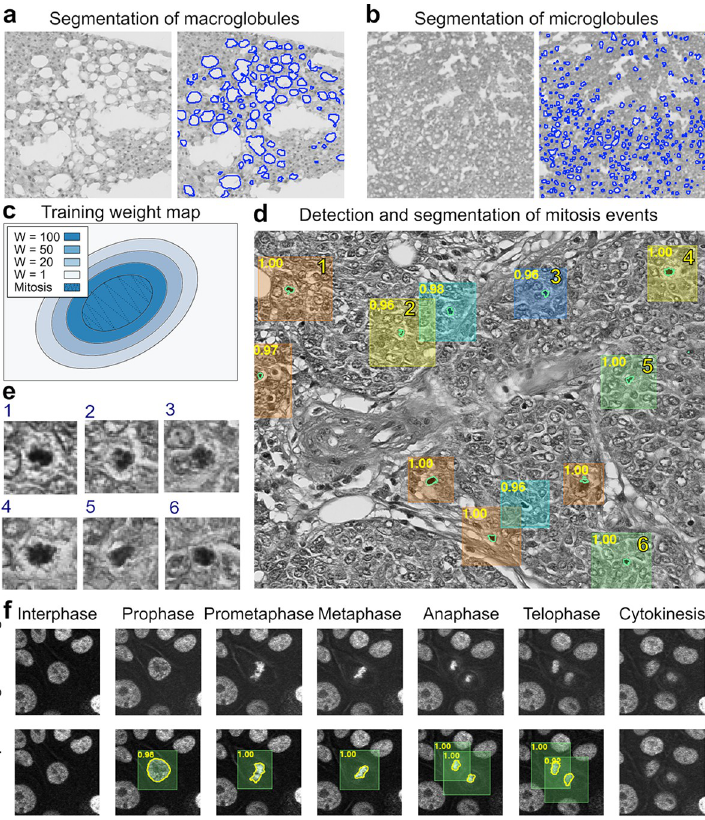
Fig 5. NuSeT can be applied to segment histopathology samples and detect mitotic events. (A, B) Representative example of liver fat globule segmentation using NuSeT. Notice that NuSeT performs well on both macroglobule (A) and microglobule (B) segmentation. (C-E) : Representative example of segmentation and detection of mitosis in breast cancer samples from ICPR 2012. (C) Weight map used for training the mitosis model. An ‘attention’ strategy has been used to focus more on the mitosis events and the environment surrounding them. The shaded region denotes the label for the mitotic event, and colors denote the weights applied during training process. (D) Representative example of mitosis detection and segmentation results with breast cancer sample. Scores on the top-left corner of the bounding boxes denote the possibility of a mitosis event evaluated from the model. Zoom-in of some detected mitotic events are shown in (E) . (F) Representative example of mitosis detection and segmentation results with fluorescent nuclei in a time lapse movie of MCF10A epithelial cells stably expressing histone H2B-eGFP. NuSeT can detect mitotic progression from prophase to telophase (mitotic events were identified by NuSeT and then manually classified into different phases).